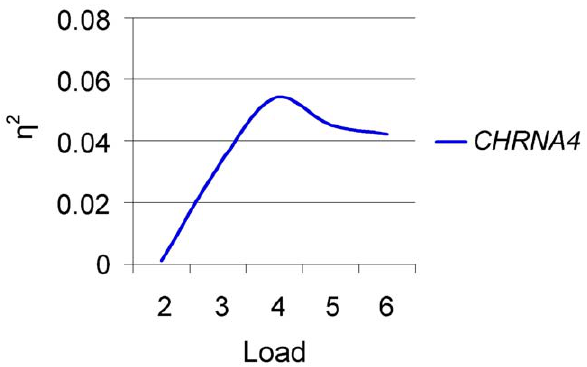
Figure 4. Estimated effect size (partial eta squared) of CHRNA4 genotype as a function of load condition in the multiple object task.